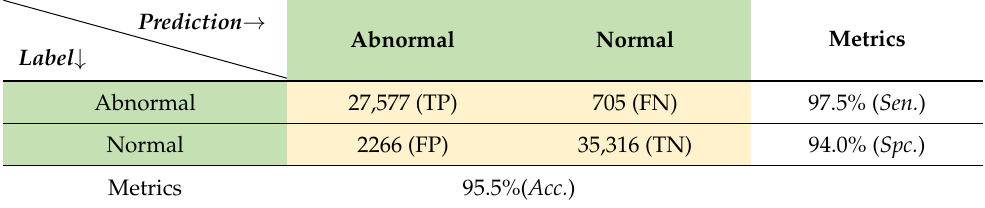
Table 11. Confusion matrix and performances of the experimental CNN for ECG